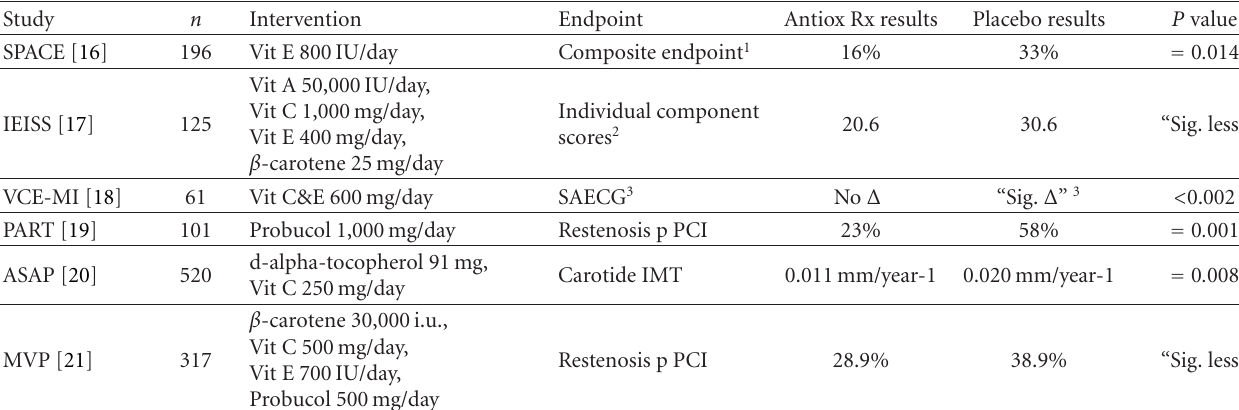
Table 1: Human proof-of-concept studies demonstrating e ff ectiveness of various antioxidant regimens on cardiovascular